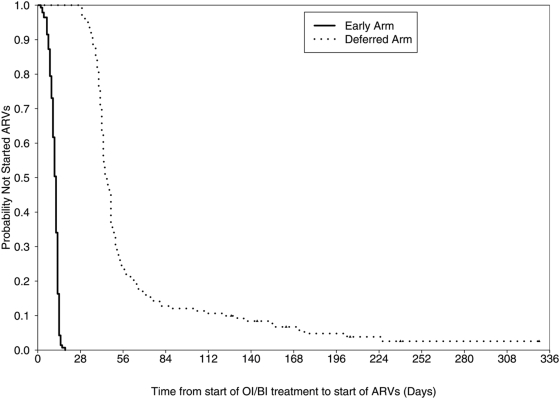
Time to ART initiation from the start of OI/BI treatment.Early arm median 12 days [IQR 9–13 days]; Deferred arm median 45 days [IQR 41–55 days].